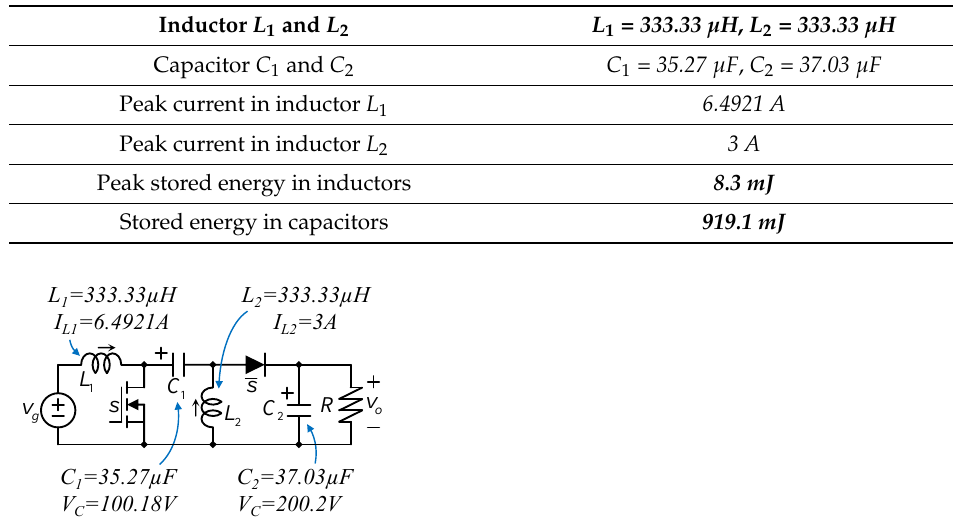
Table 5. SEPIC converter results.